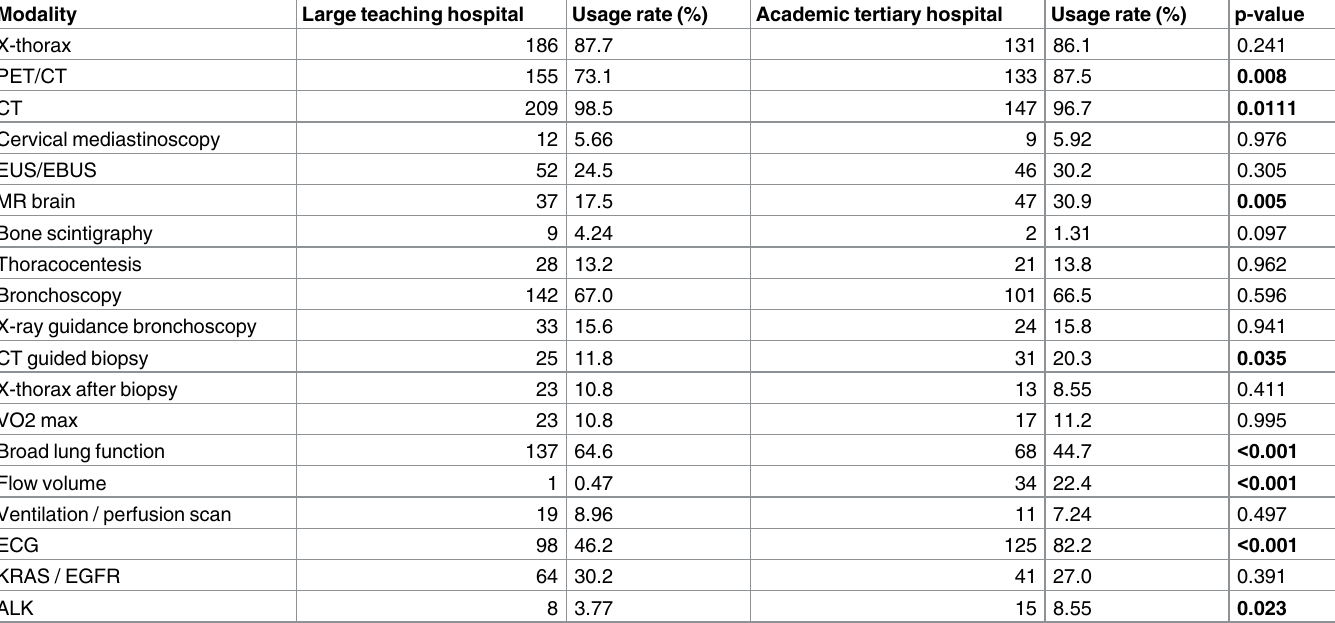
Table 2. Usage of diagnostic procedures in diagnostic